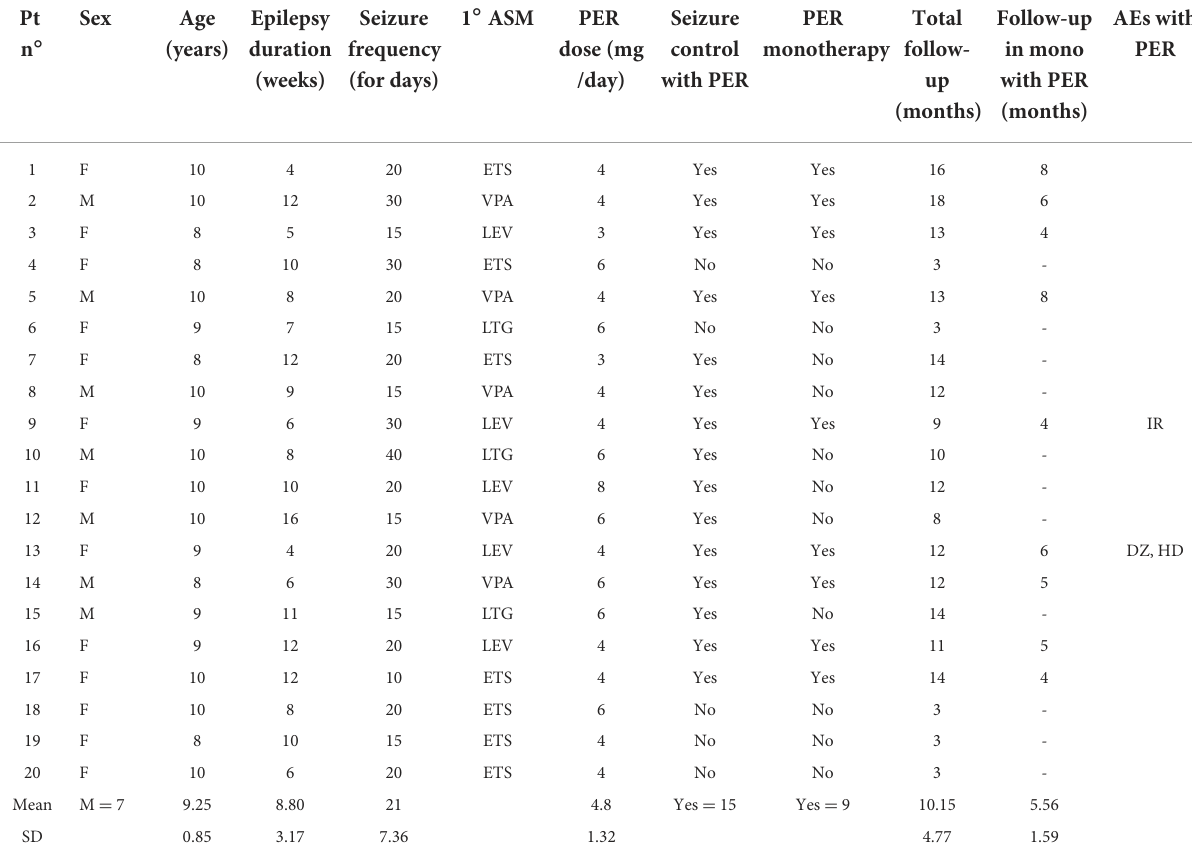
TABLE 1 Sample clinical and demographic